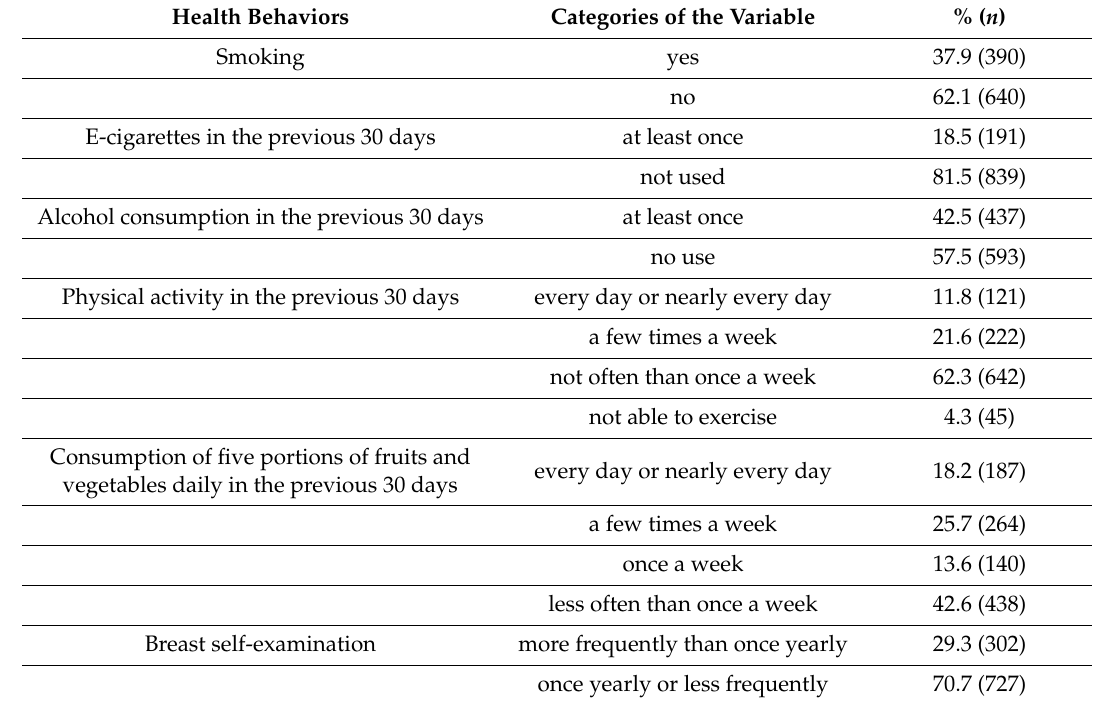
Table 2. Health behaviors in the study